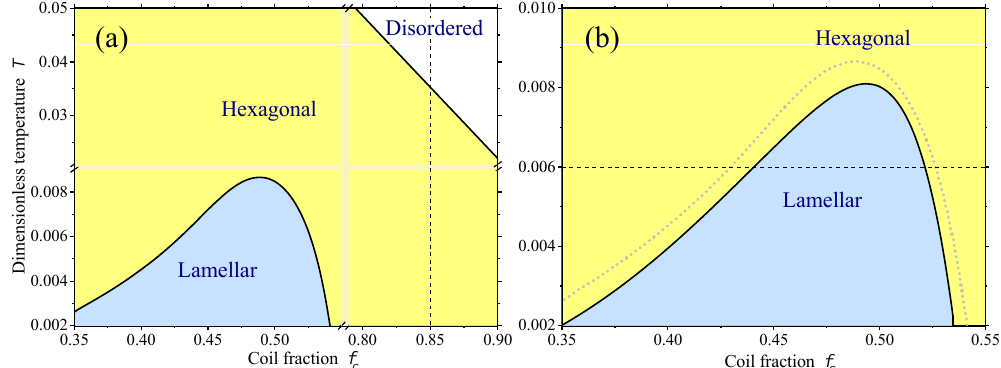
Figure 1. Coil fraction f c – dimensionless temperature T = ( β J 0 ) − 1 phase diagrams of the rod-coil diblock copolymer calculated numerically for N = 10, χ = 2, and J 2 = J 0 /3: the diagram obtained by numerical minimization of the free energy with respect to all order parameters ( a ); and a part of the diagram obtained for low f c within the S = 1 approximation as discussed in the text. The dashed straight lines correspond to the order parameter profiles presented in Figure 2. The dotted curve in ( b ) represents the lamellar-hexagonal boundary calculated as in ( a ) without using the approximation of perfect orientational order.